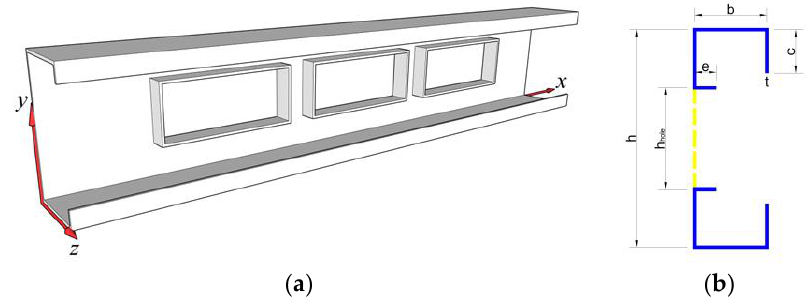
Figure 1. Lipped channel with stiffened rectangular holes on the web: ( a ) 3D viewpoint and ( b ) the perforated cross-section.